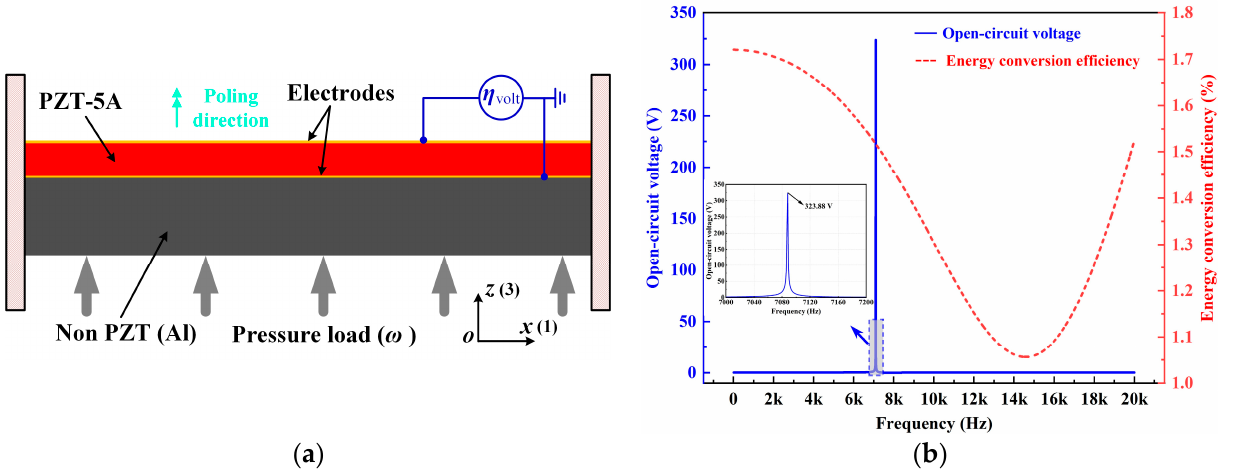
Figure 2. Schematic diagram and frequency response curve of PEH. ( a ) Schematic cross ‐ section of a harmonically pressured clamped–clamped piezoelectric plate; ( b ) frequency responses of the open ‐ circuit voltage and the energy conversion efficiency.